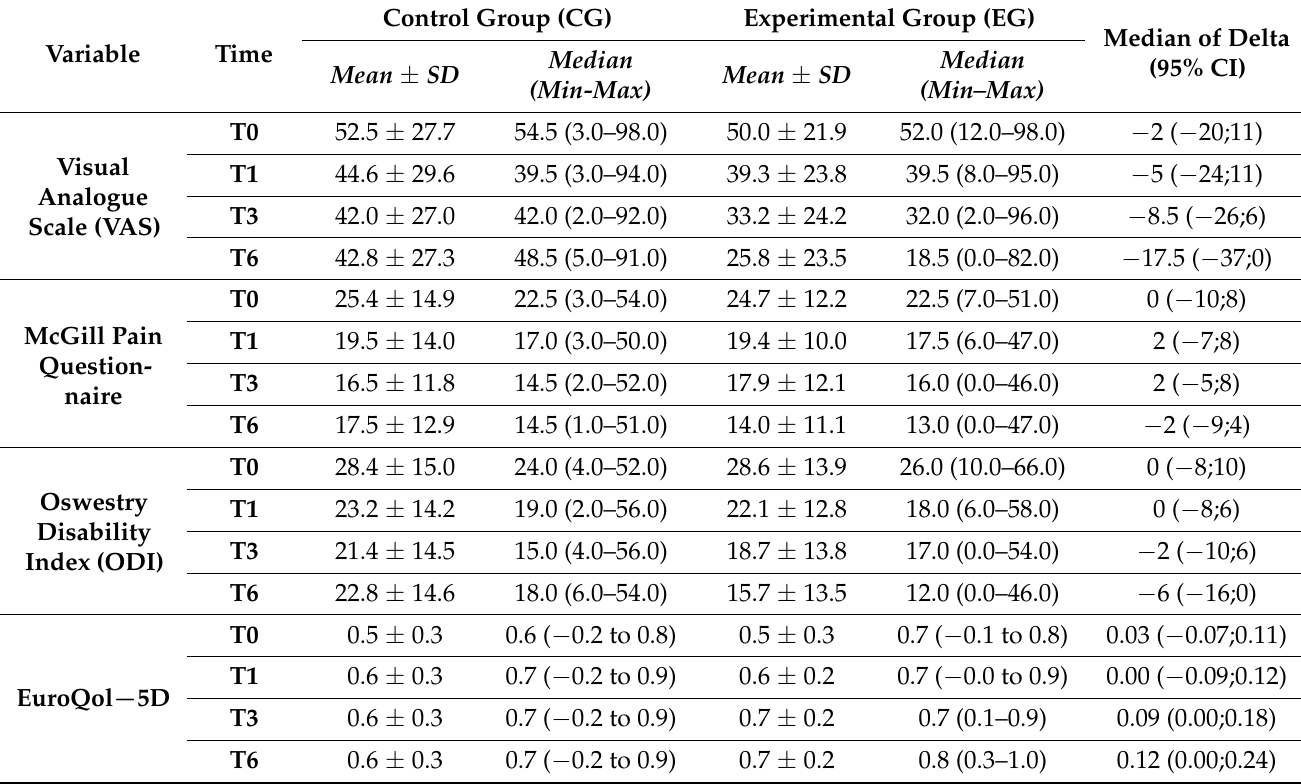
control and the experimental group. Table 2. Scores obtained in two treatment groups for all outcome measures at each timeline evaluation.